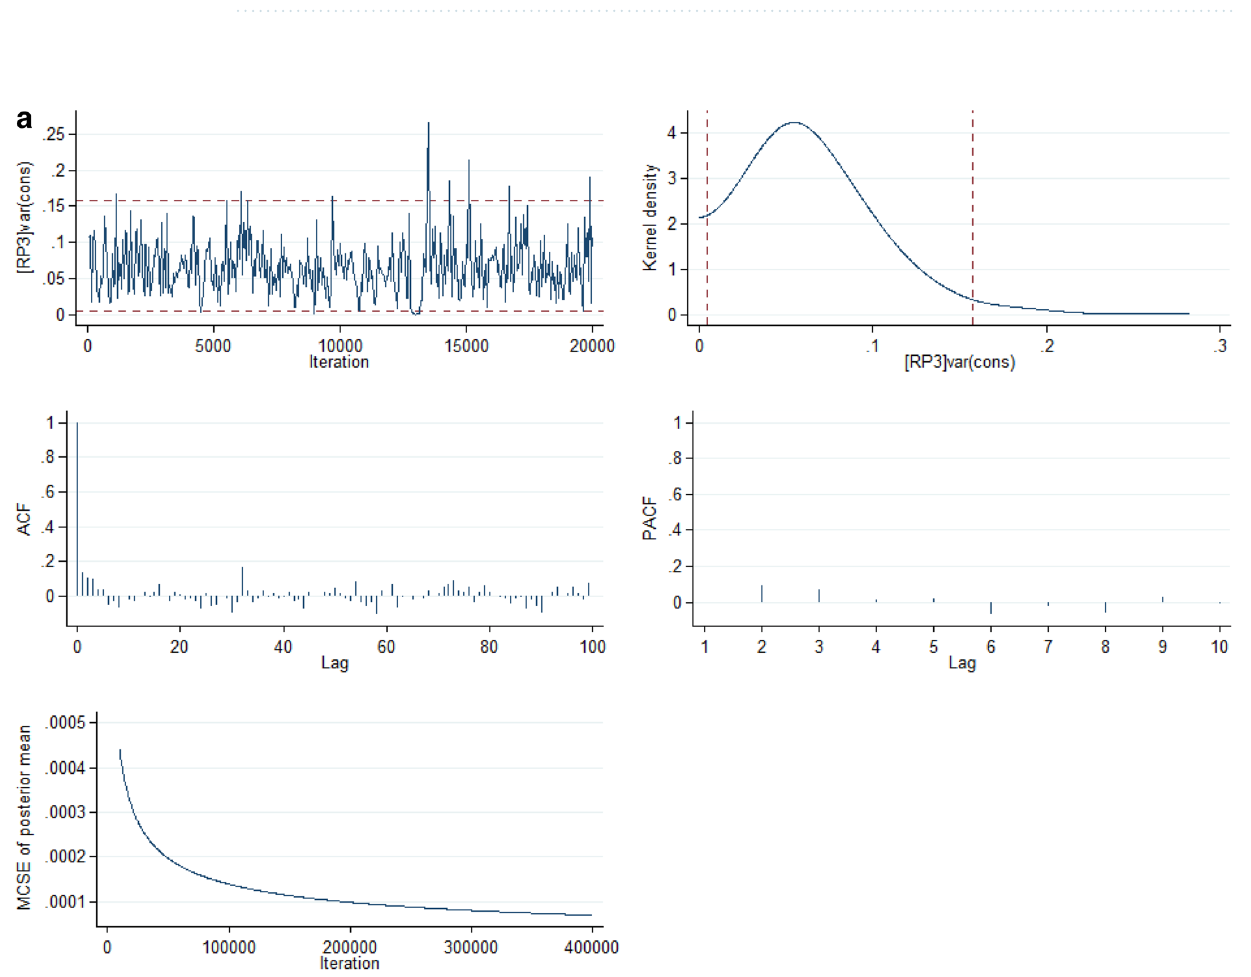
Figure 3. ( a ) Five-way MCMC graphical diagnostics of Model 5 for Infant mortality at the state level. ( b ) Five- way MCMC graphical diagnostics in Model 5 for Infant mortality at the neighbourhood